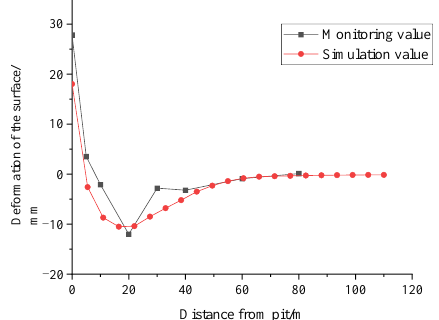
Figure 13. Contrast curve of surface deformation.